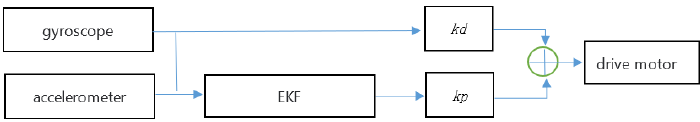
Figure 13. PID software flow chart.